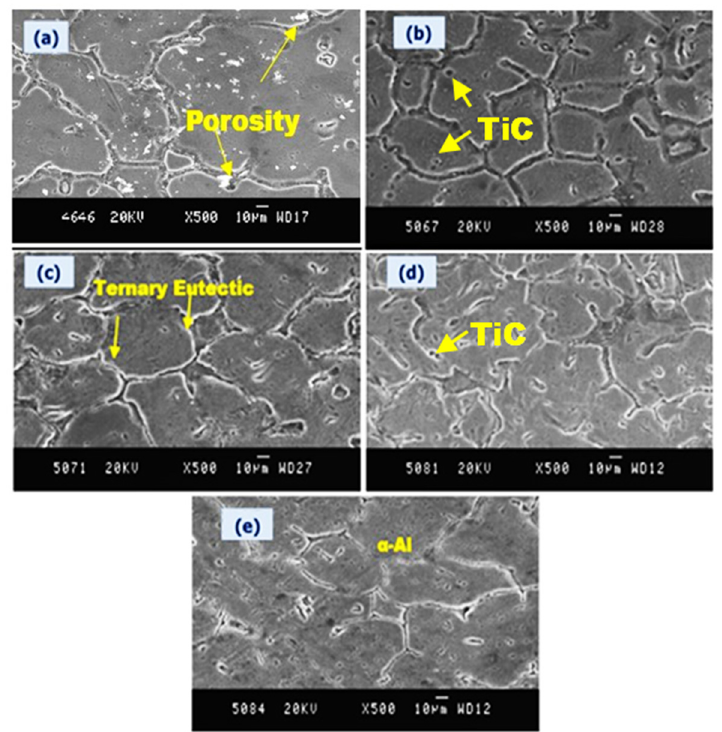
Figure 4. SEM images of Al6061-TiC MMCs at 500× magnification (scale: 10 µm): ( a ) Al6061 base alloy; ( b ) Al6061-2 wt.% TiC; ( c ) Al6061-4 wt.% TiC; ( d ) Al6061-6 wt.% TiC; and ( e ) Al6061-8 wt.% TiC.